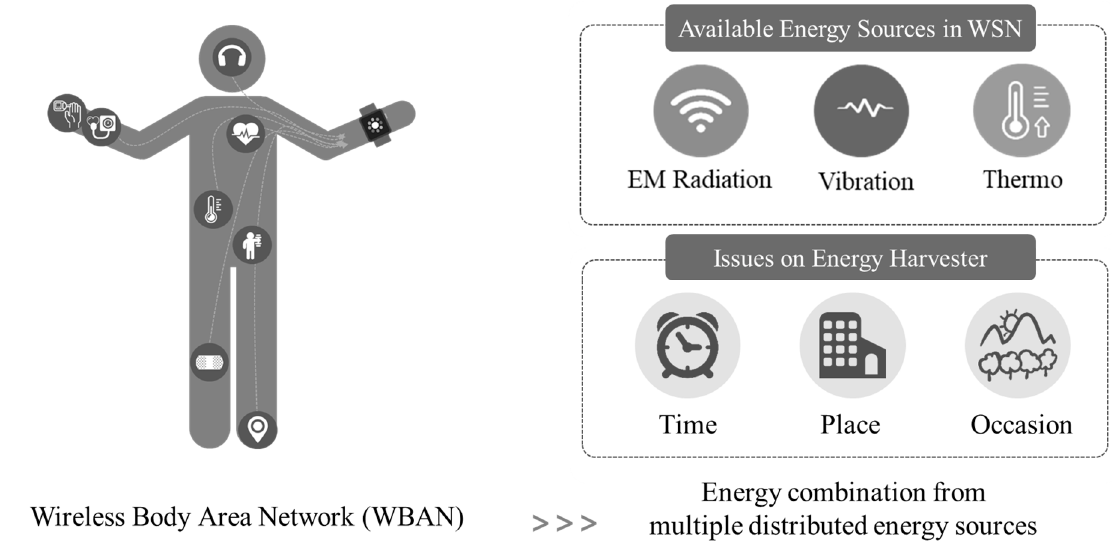
Figure 1. Energy management for a wireless body area network (WBAN).